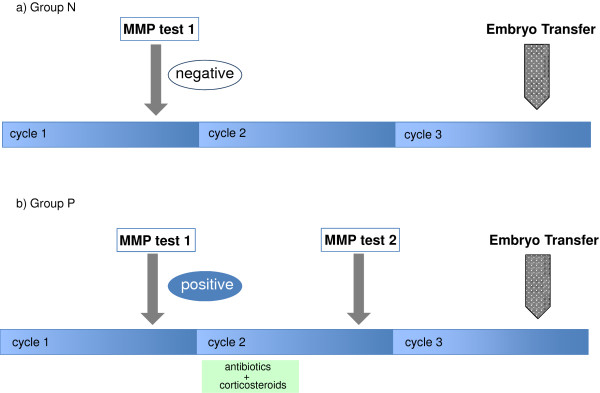
A schedule of the MMP tests, the medication and the next embryo transfer. According to the results of the first MMP test, all the patients were divided into two groups, Group N (Panel a) and Group P (Panel b). Group P patients who had shown a positive result had a two-week treatment composed of antibiotics and corticosteroids at the next proliferative phase (panel b). After the treatment, Group P patients had the 2nd MMP test at the mid luteal phase of the same cycle, whereas Group N patients did not have the 2nd test (Panel a). In the subsequent cycle (the next cycle after the completion of the treatment), Group P patients had the next embryo transfers.